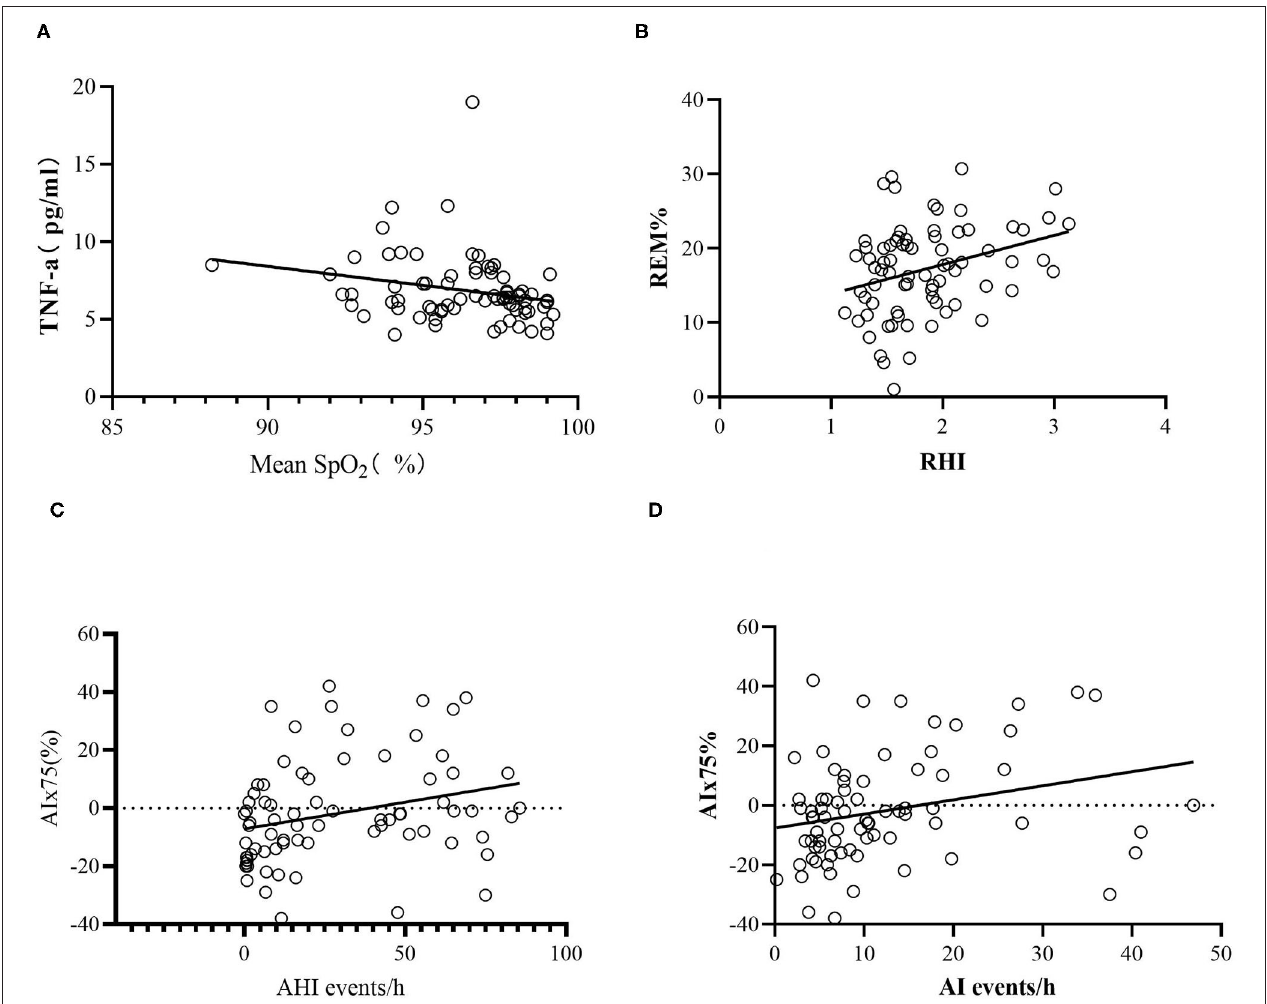
FIGURE 3 | Scatter plots of laboratory data. (A) The relative associations between TNF- α and mean SpO 2 . (B) The relative associations between REM% and RHI. (C) The relative associations between AIx75 and AHI. (D) The relative associations between AIx75 and AI. AHI, apnea hypopnea index; AI, arousal index; AIx75, augmentation Index@75 beats/minute; SpO 2 , oxygen saturation; TNF- α , tumor necrosis factor alpha; REM%, the percentage of stage rapid eye movement in total sleep time; RHI, reactive hyperaemia